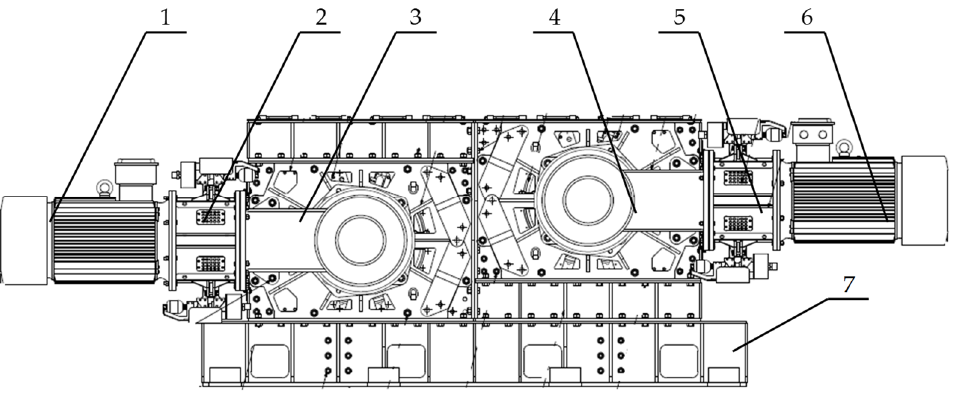
Figure 4. Conveyor drive unit, where; 1—engine, 2—left brake system (I), 3—left gearbox (I), 4—right gearbox (II), 5—right brake system (II), 6—engine, 7—foundation.